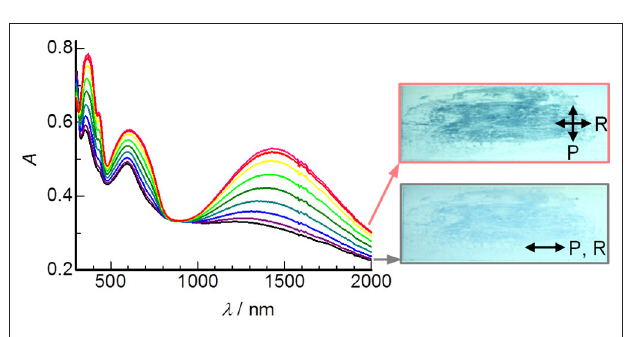
FIGURE 6 | Variations of polarized UV-Vis-NIR spectra of DHP(8-12)-TCNQ rubbed film with changing the angle between the polarizer (P) and rubbing (R) direction in steps of 10 ◦ . Lower and upper insets show transmission images of the film taken in P || R (black) and in P ⊥ R (red), respectively.